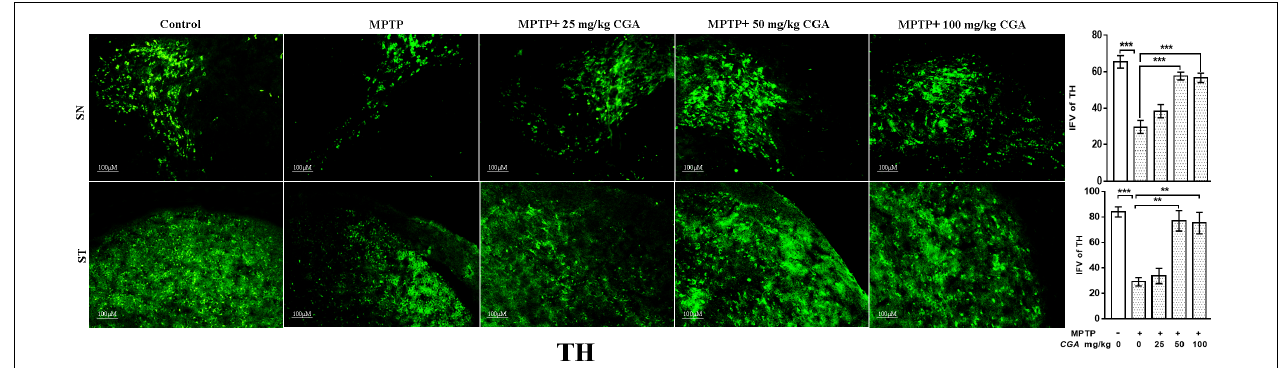
FIGURE 5 | Immunohistochemistry of tyrosine hydroxylase in the SN and striatum of mice. With 10 × magnifications after staining. The expression of TH and nerve terminal density were significantly decreased in the SN and ST of MPTP-injected mice compared with the control group, whereas the expression of TH significantly increased in CGA-treated group compared with MPTP-injected mice. Values are expressed as mean ± SEM ( n = 3). ∗ p < 0.05, ∗∗ p < 0.01, and ∗∗∗ p < 0.001. CGA, chlorogenic acid; MPTP, 1-methyl-4-phenyl-1,2,3,6-tetrahydropyridine; SN, substantia nigra; TH, tyrosine hydroxylase; ST, striatum; SEM, standard error of mean; IFV, integrated fluorescent value.